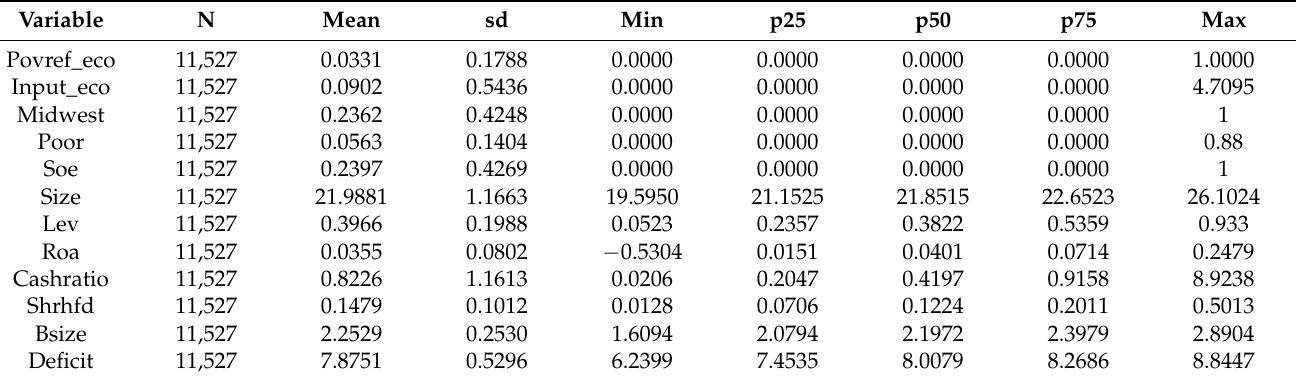
Table 2. Descriptive statistics for key variables.